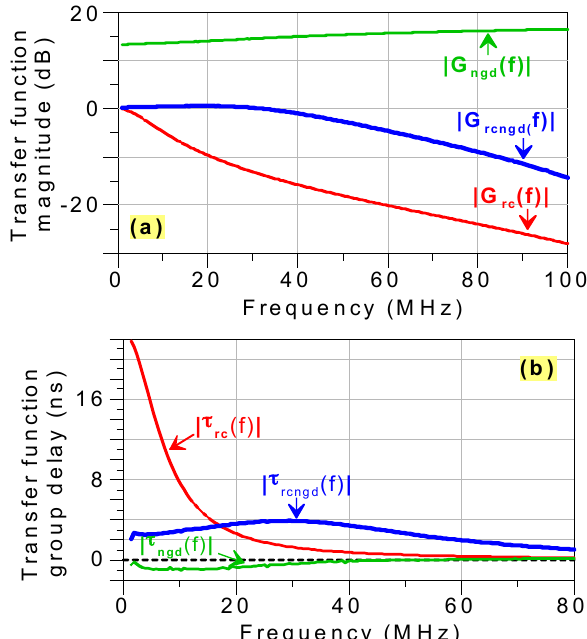
Figure 18: Measurement results of the transfer functions from the RC-, NGD- and RCNGD-circuits tested. (a) Magnitude and (b) group delay.